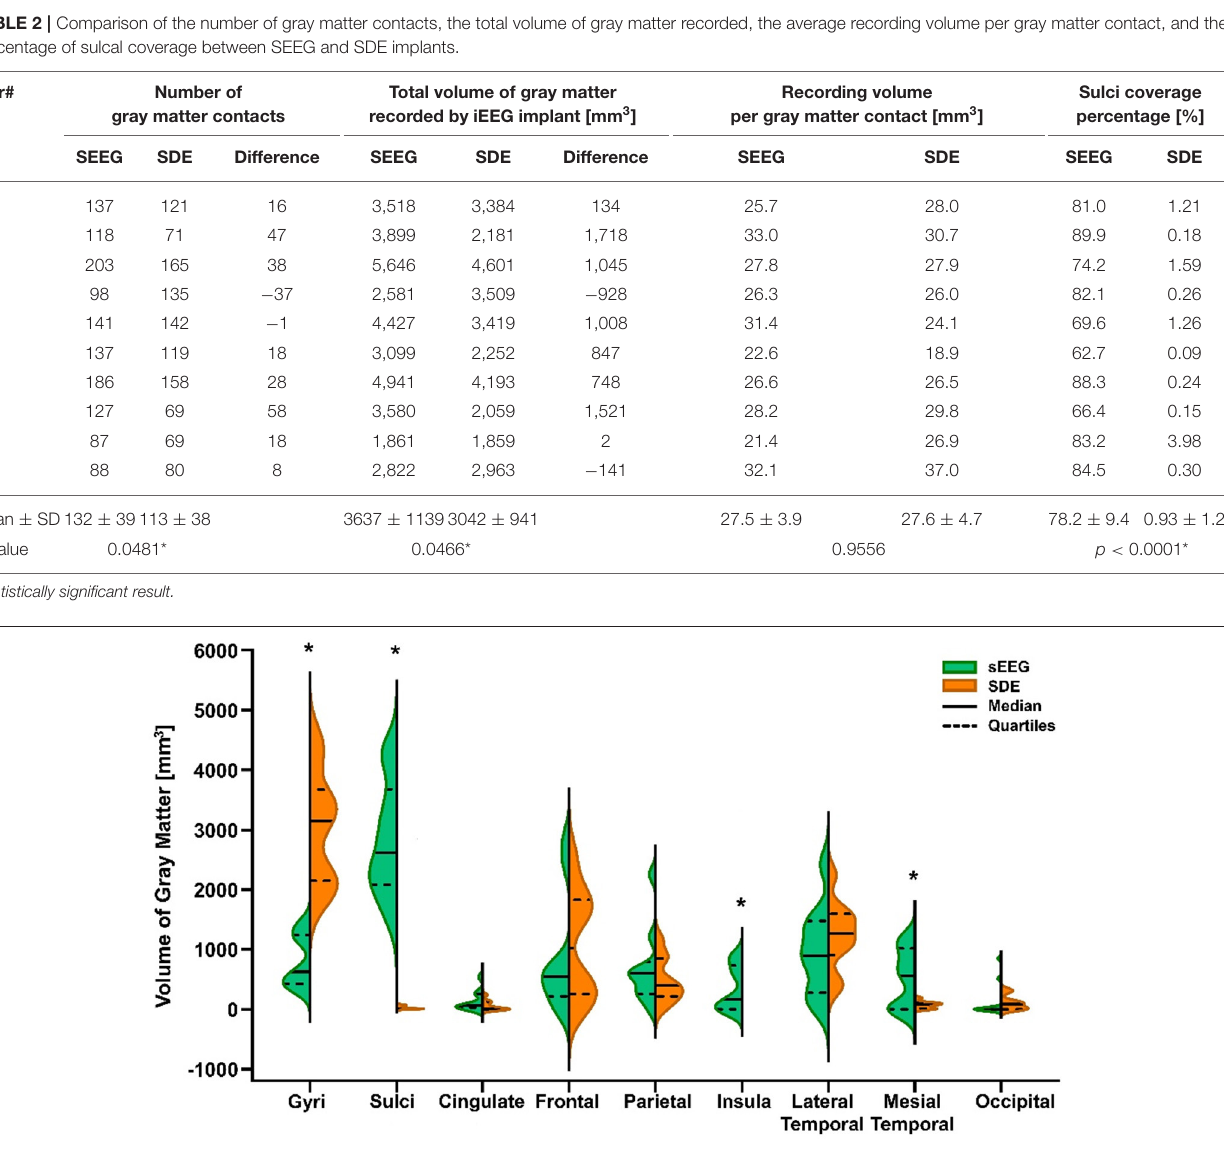
temporal cortex (Wilcoxon test, p = 0.0273) in the SEEG